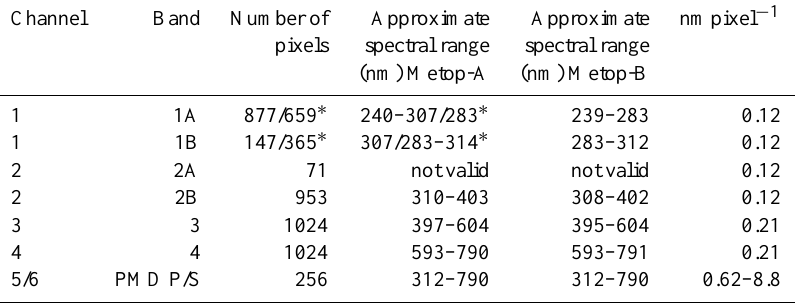
Table 3. Main channel band settings of GOME-2. The band separation change between band 1A and B occurred for GOME-2 on Metop-A during orbit 11119 on 10 December 2008. For GOME-2 on Metop-B the updated settings have been used from the beginning of operations.